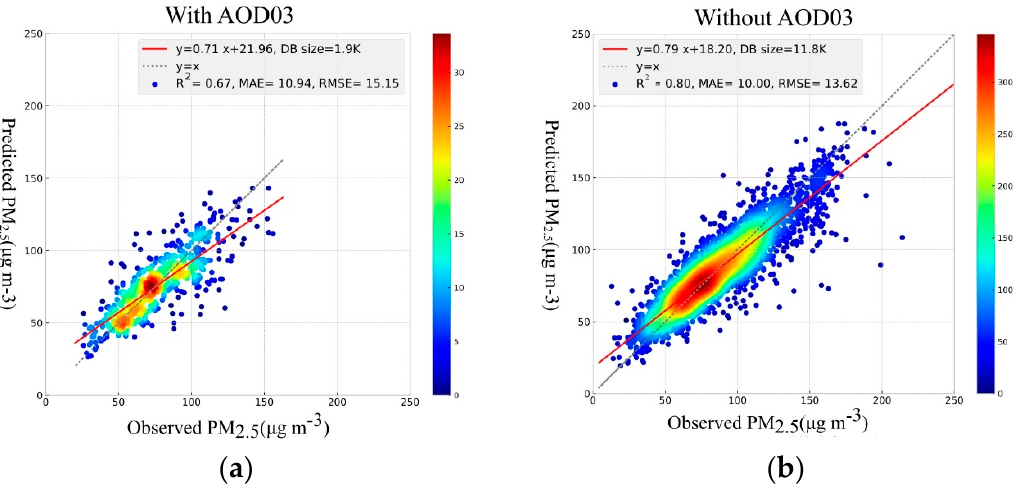
Figure 4. Scatter plot of predicted PM 2.5 versus observed values using the XGBoost method. ( a ) Scatter plot of predicted vs. observed PM 2.5 including AOD03. ( b ) Scatter plot of predicted vs. observed PM 2.5 excluding the AOD03 variable. The line in red shows a linear regression between observed and predicted PM 2.5 values for the test dataset.